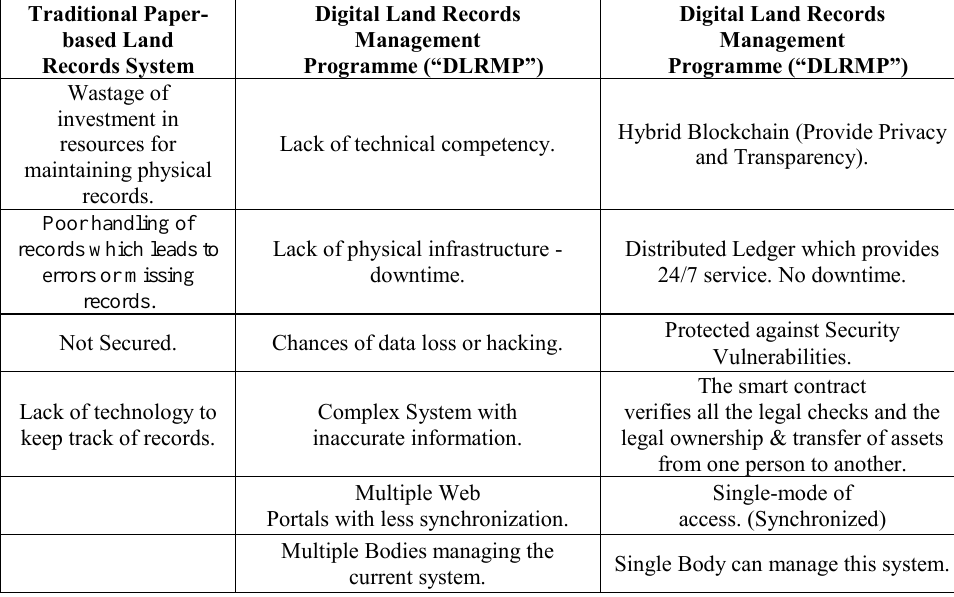
Table 1. Comparative table of traditional, existing, and our proposed